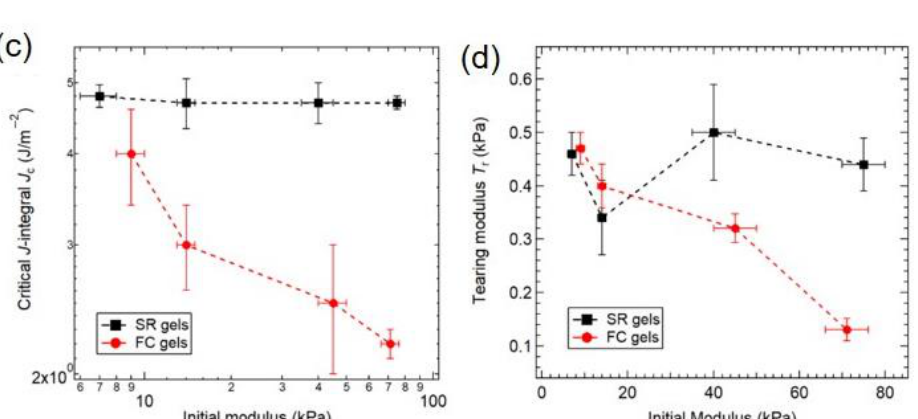
Figure 14. Gray scale photos and retardation maps of ( a ) SR gel with 25% CD coverage and ( b ) SR gel with 2% CD coverage during crack propagation. Reprinted from [29] with permission from IOP Science.